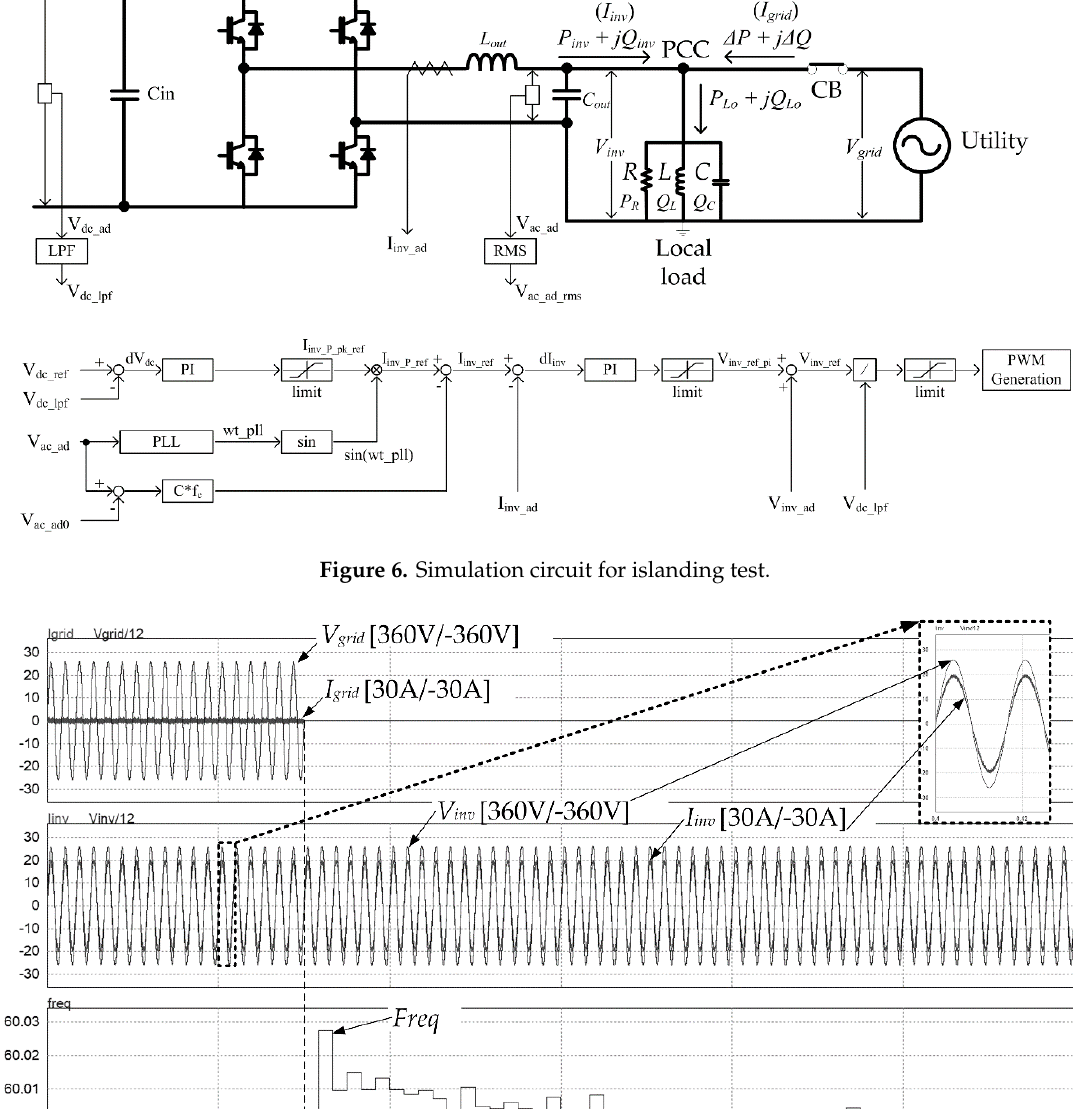
Figure 7. Islanding test results when no anti-islanding method is used.